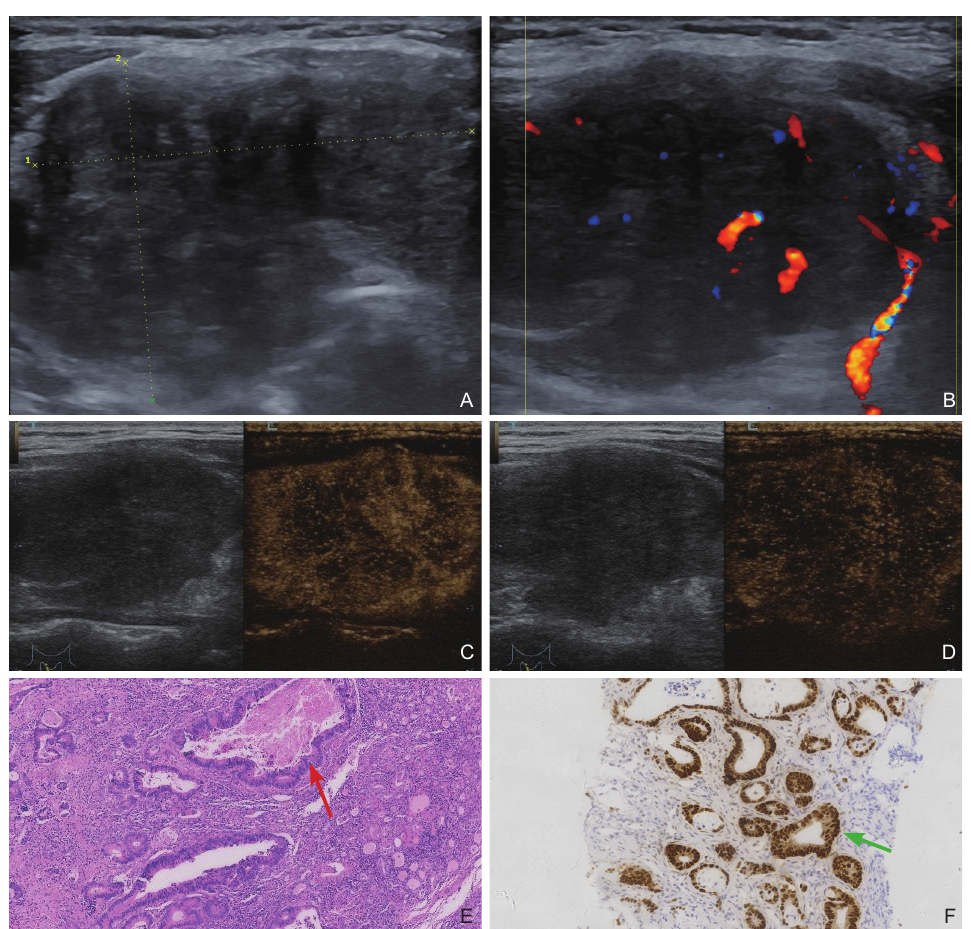
Figure 1 Conventional US, CEUS, and surgical pathological images in case one. (A) Two-dimensional US showed a hypoechoic mass in the right lobe and isthmus of thyroid gland, with unclear margin, irregular shape, heterogeneous internal echotexture and local capsule protuberated; (B) Rich and irregular blood flow signals were detected in and around the mass; (C) CEUS showed irregular low enhancement at 17s of arterial phase, and the tumor boundary was more clear than two-dimensional US with discontinuous capsule; (D) CEUS showed early and rapid washout of the mass (20s); (E) HE staining, 100 × magnification (red arrow indicated follicular cells); (F) Immunohistochemical staining, 200 × magnification (green arrow indicated CDX-2 high positive cells, suggesting colon